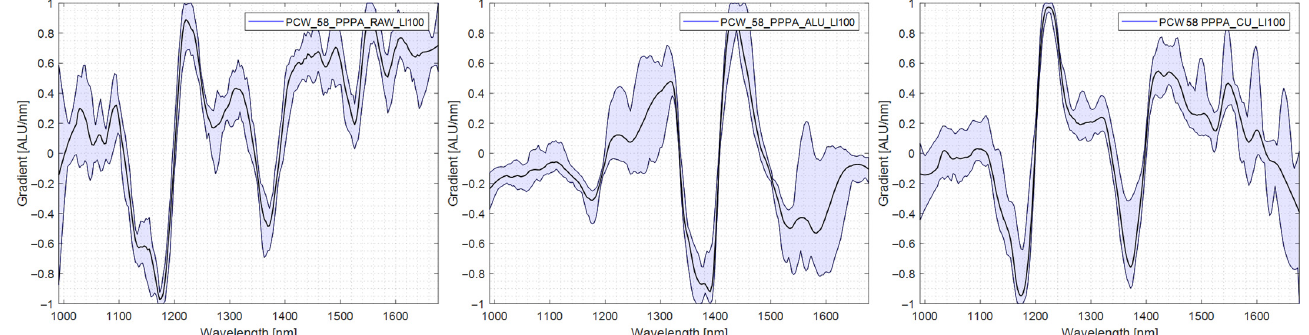
Figure 19. Comparison PP/PA spectra, left: no reflector, middle: aluminium reflector, right: copper reflector.